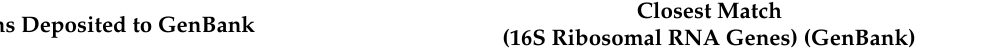
Table 2. Sequence similarities of rhizosphere bacteria isolated from roots of Portulaca oleracea L. with the closest sequences registered in GenBank.